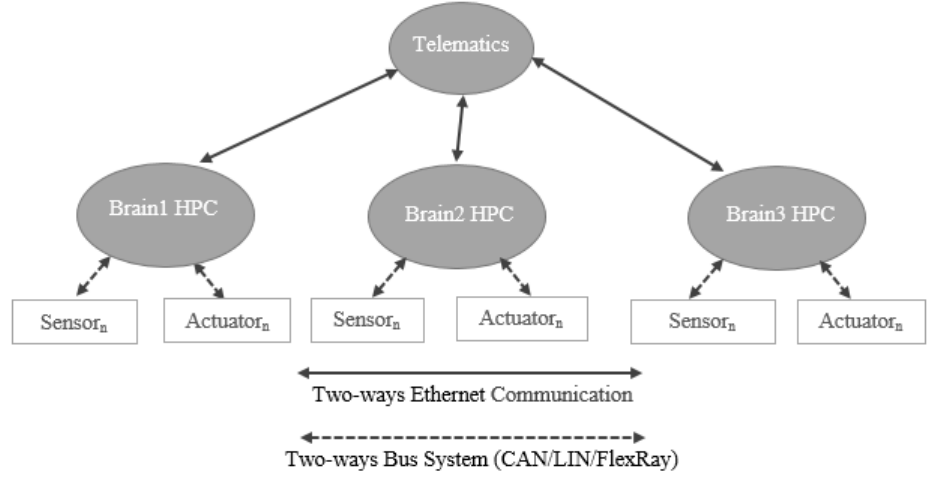
Figure 16. Representation of Three-Brain E/E